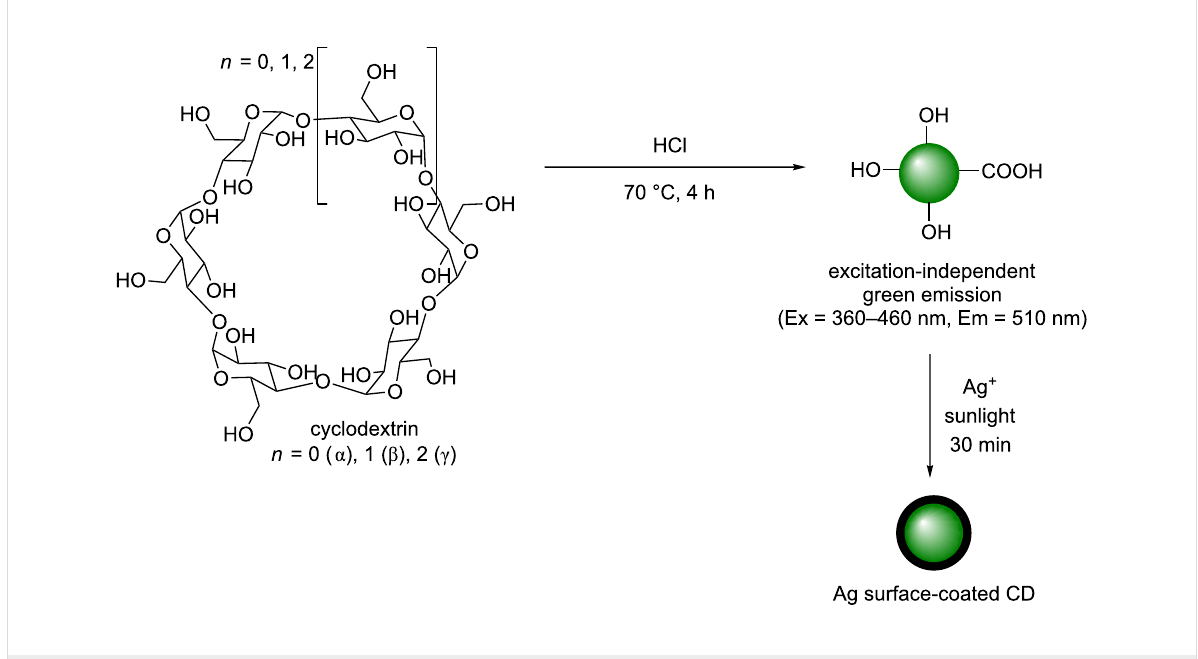
Scheme 23: Cyclodextrin-derived CDs used for detection of Ag + ions in solution, based on the formal reduction of Ag + to afford plasmonic Ag.